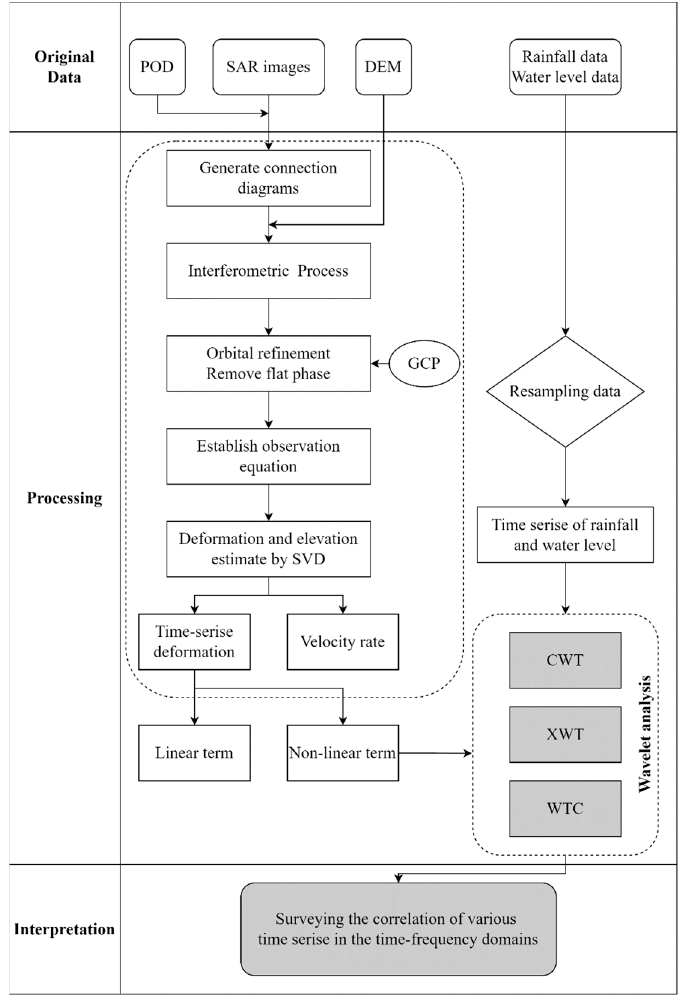
Figure 2. Flowchart of data processing, including time series InSAR and wavelet analysis.